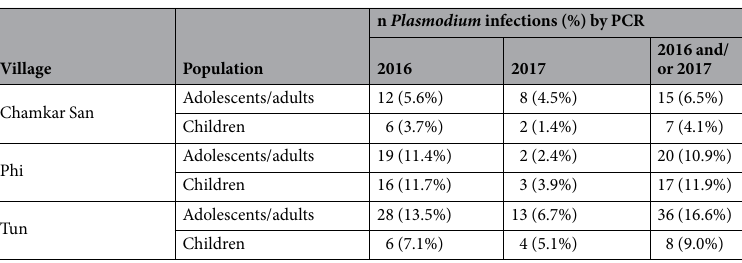
Table 2. Prevalence of Plasmodium infection by village for respondents to cross-sectional